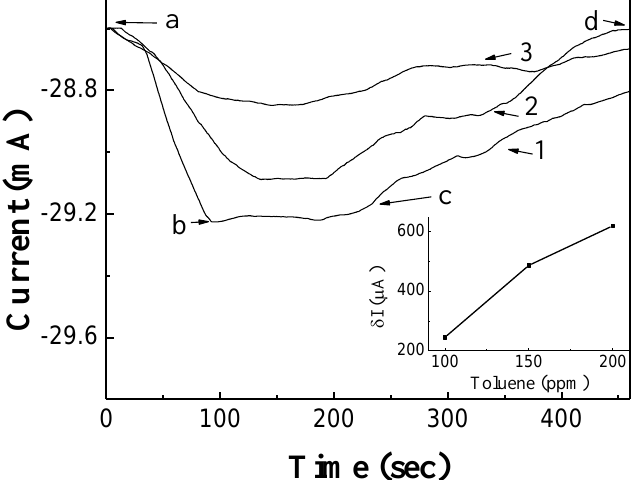
Figure 5. Realtime characteristics (reponse and recovery data) for a toluene concentration of: (1) 200 ppm, (2) 150 ppm, and (3) 100 ppm. (a) Injection of toluene gas into the gas chamber, (b) sturation, (c) benting toluene gas through the gas line(out), and (d)